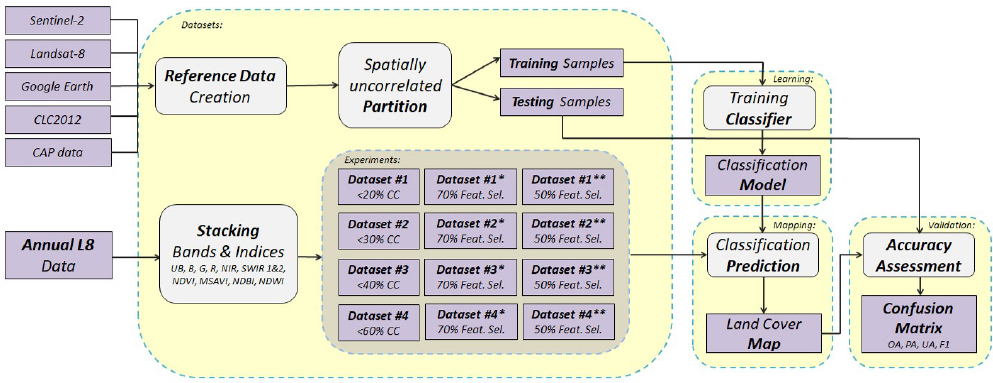
Figure 3. A flowchart of the proposed classification framework and performed SVM experiments with Landsat-8 (L8) datasets of different cloud cover (CC) and additional feature selection (Feat.